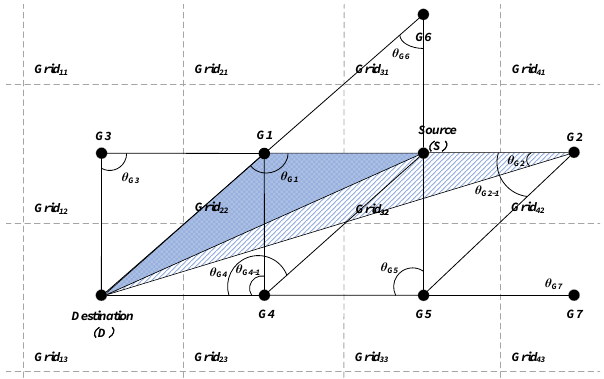
Figure 8. Schematic diagram of angle and area formed by end grid, start grid, and next